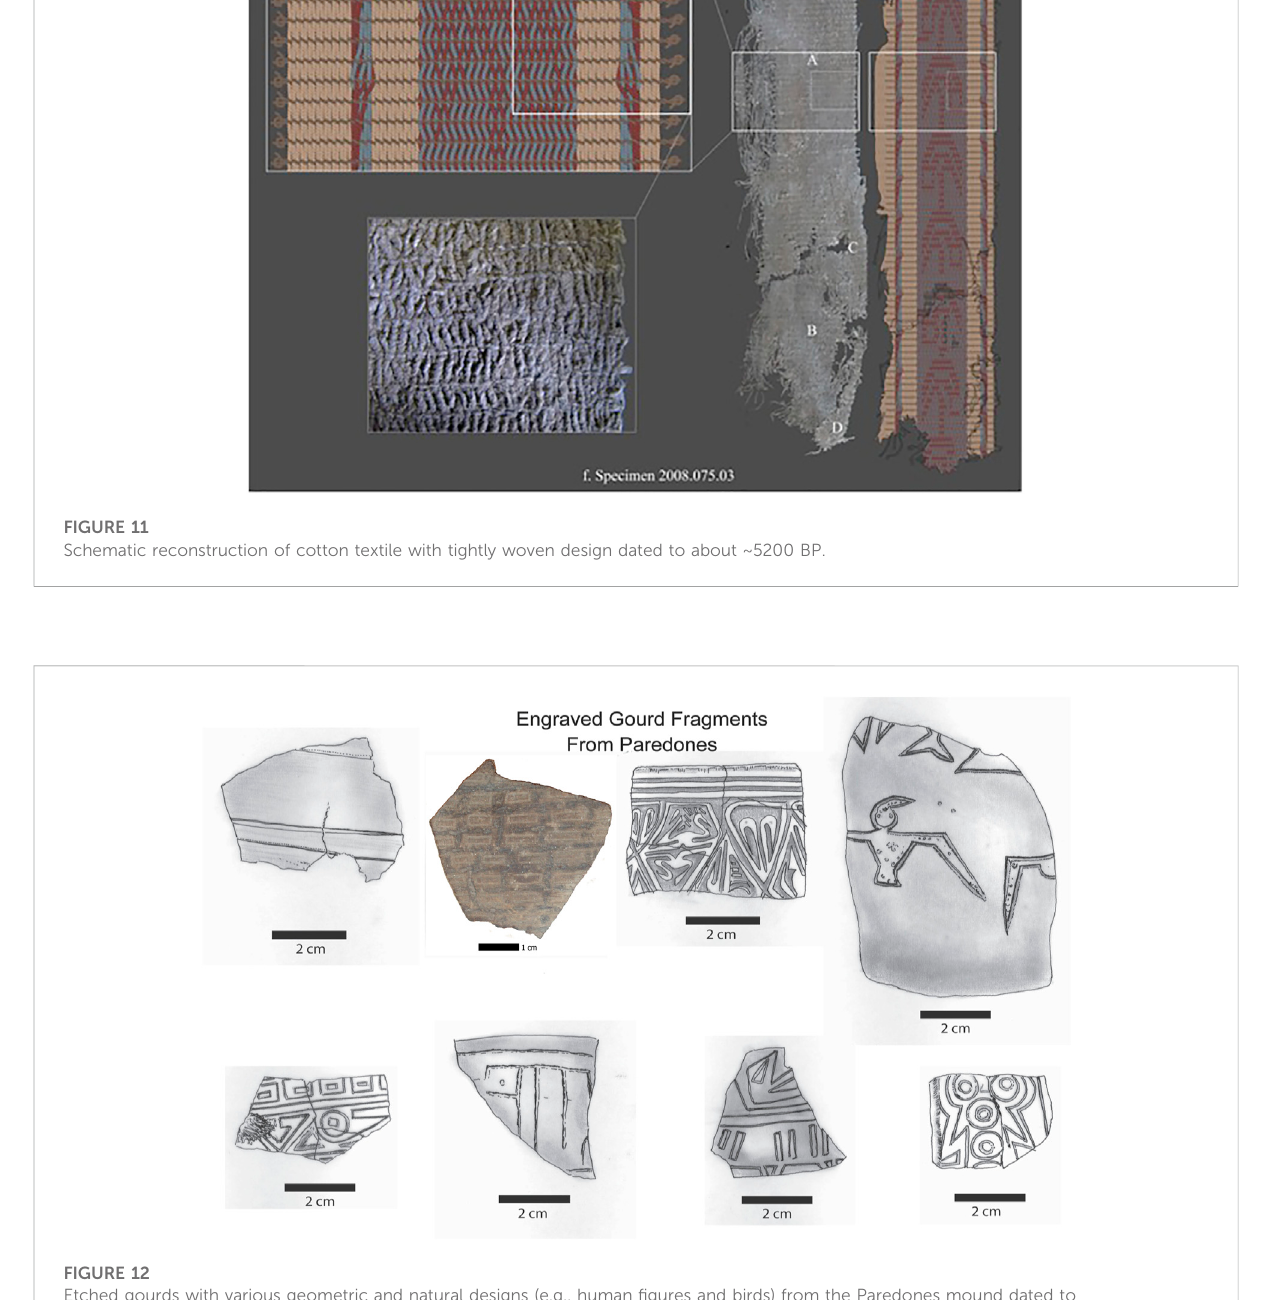
Etched gourds with various geometric and natural designs (e.g., human fi gures and birds) from the Paredones mound dated to ~5,800 – 5,000